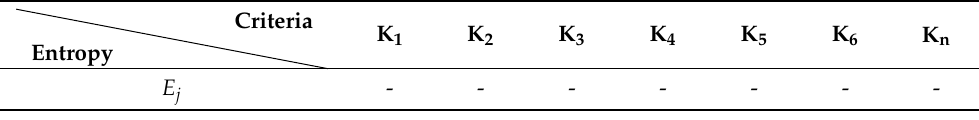
Table 8. The level of entropy E j . Entropy